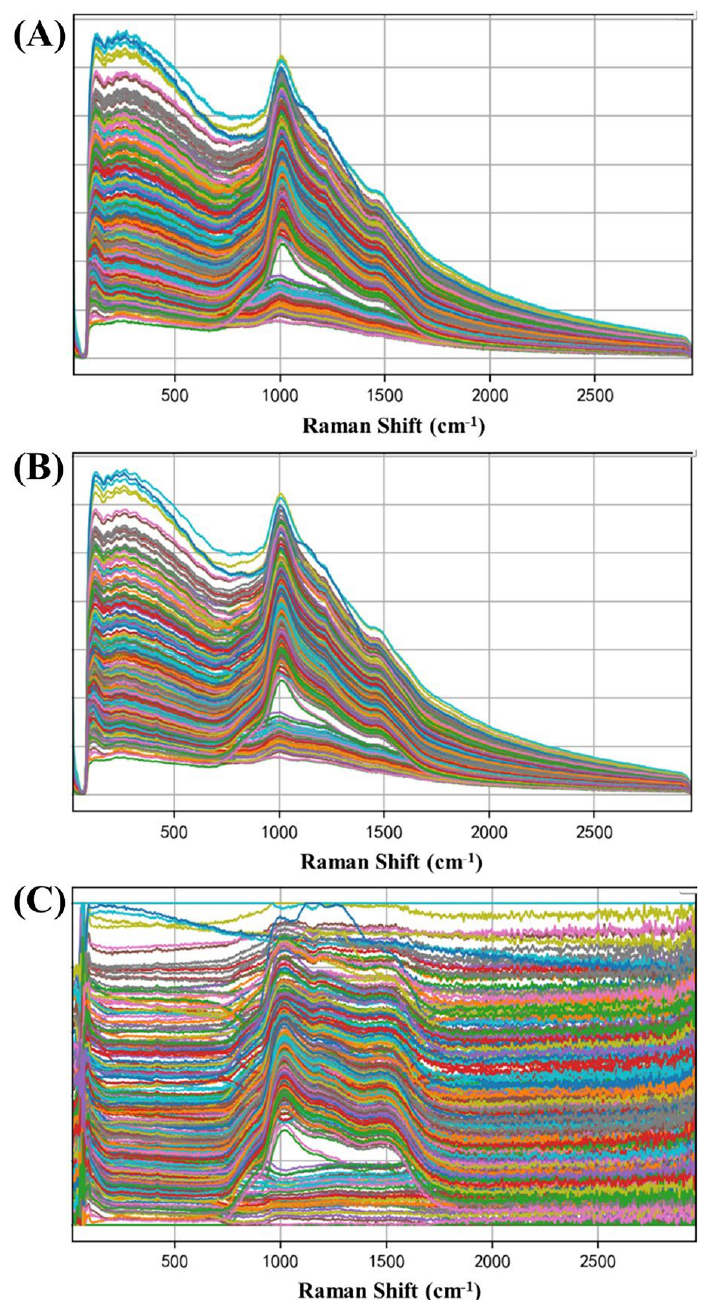
Figure 3. Raw Raman spectra ( A ) and spectra preprocessed by S − G ( B ) and Minmax ( C ) of water extract samples.